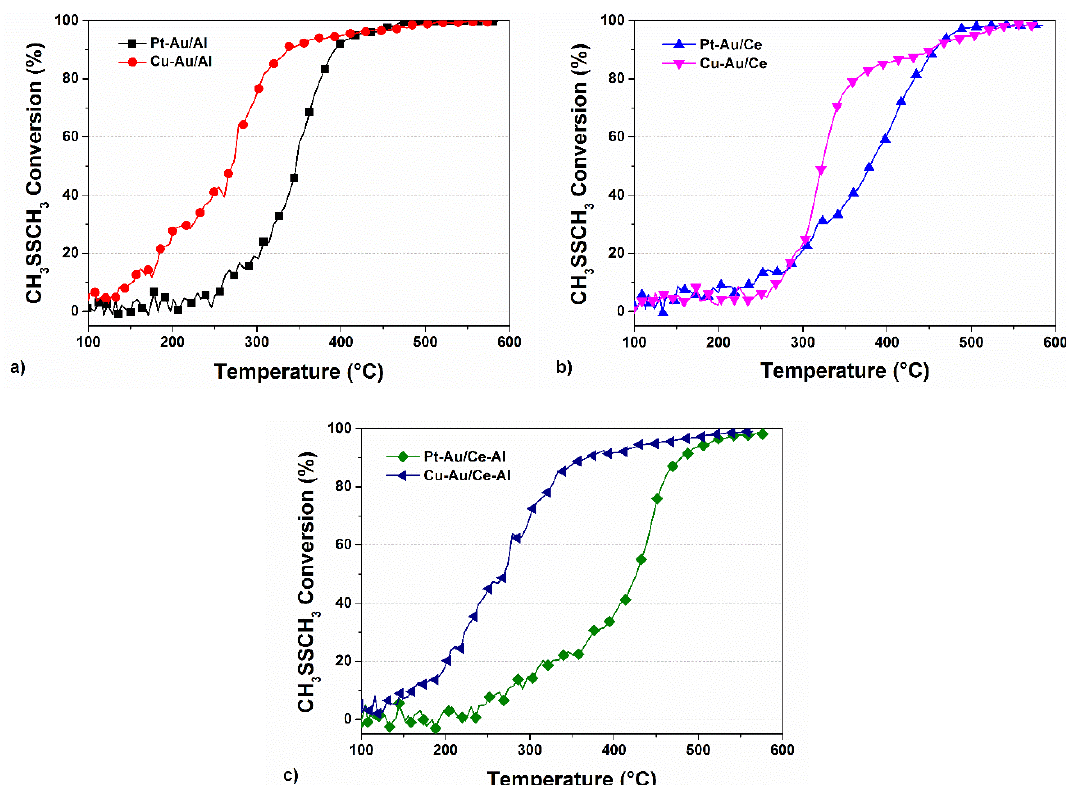
Figure 9. The activity of Pt–Au and Cu–Au catalysts on ( a ) γ -Al 2 O 3 , ( b ) CeO 2 , and ( c ) CeO 2 –Al 2 O 3 in the oxidation of dimethyl disulfide (DMDS) (DMDS 500 ppm, weight hourly space velocity (WHSV) 720 g g cat − 1 h − 1 , 5 °C min − 1 ).